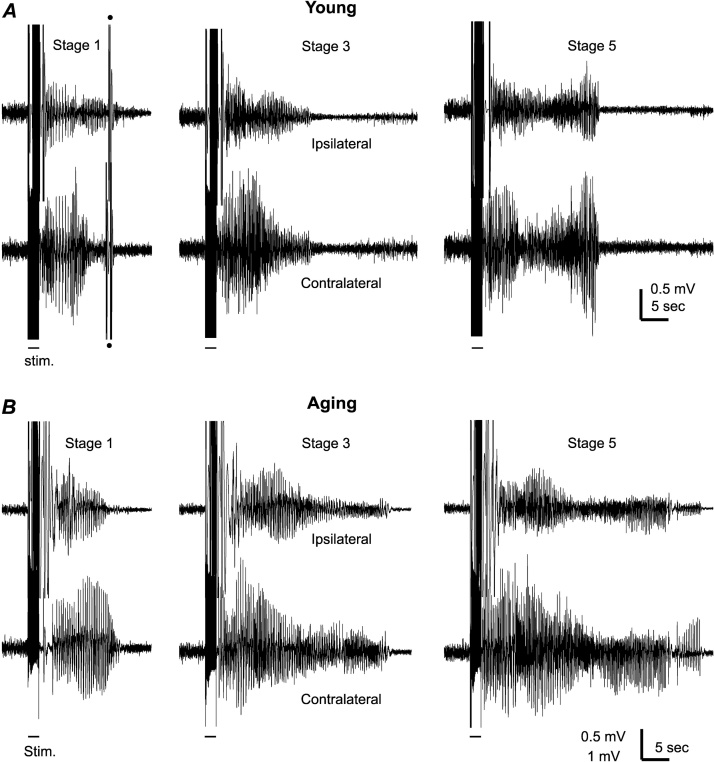
Examples of evoked hippocampal AD.Bilateral hippocampal AD corresponding to stage 1, 3 and 5 motor seizures were collected from a young mouse (A) and an aging mouse (B). The times of applied stimulation (60 Hz for 2 s) were indicated by short bars below traces. ‘Ipsilateral’ and “contralateral” were in reference to the kindling stimulation site. Artifacts were marked with filled circles. Post-stimulation artifacts in ipsilateral traces were due to switches between stimulating and recording modes in the amplifier used (see Methods).